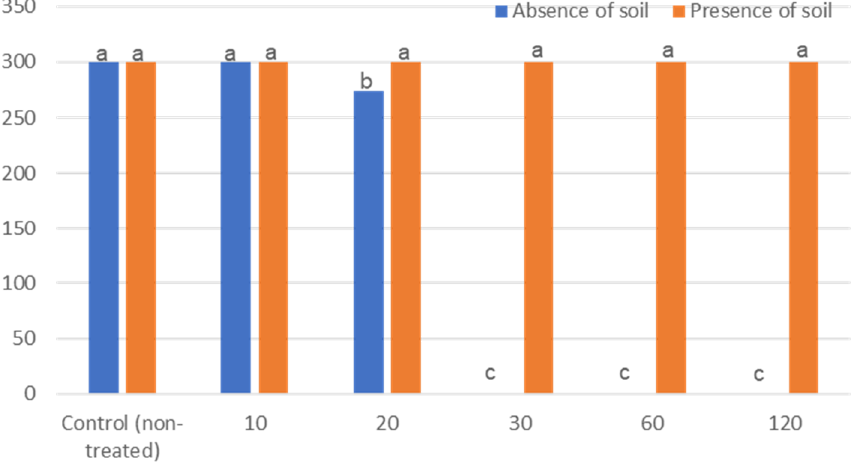
Figure 4. Treatment of Fusarium oxysporum f. sp. cubense -contaminated water in the presence and absence of soil with peracetic acid. Significant differences ( p ≤ 0.05) according to Tukey’s test are indicated by different letters.